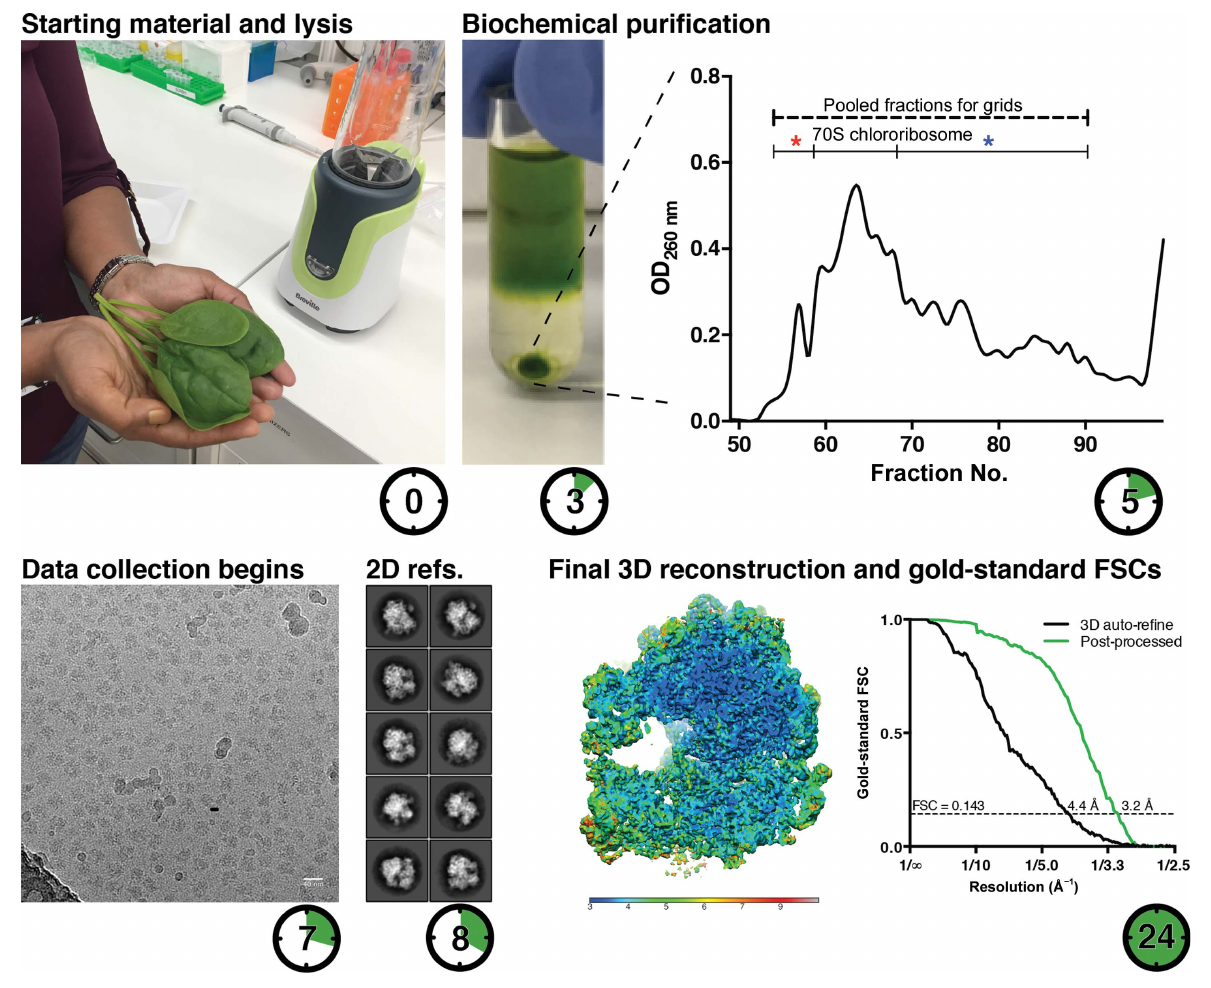
Figure 1 Cryo-EM structure determination of the chlororibosome to 3.2 A˚ resolution within 24 h. The experiment started with seven spinach leaves and chlororibosomes were purified within 5 h, appearing as a major peak in the sucrose gradient. Contaminating fractions labelled with asterisks were included for grid preparation. Data collection started after 7 h, and micrographs exhibited ice contamination owing to high humidity conditions during grid handling. The data were processed on-the-fly, resulting in a 3.2 A˚ resolution reconstruction after 24